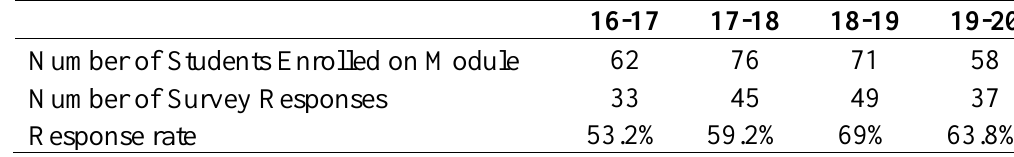
Table 1: Breakdown of Response Rate by Cohort Surveys were designed to collect general module feedback and included five additional questions specific to the use of reflective online diaries. The scaling technique included multiple choice and Likert scales, concluding with one open-ended response question, giving apprentices an opportunity to provide additional feedback on the reflective online sales